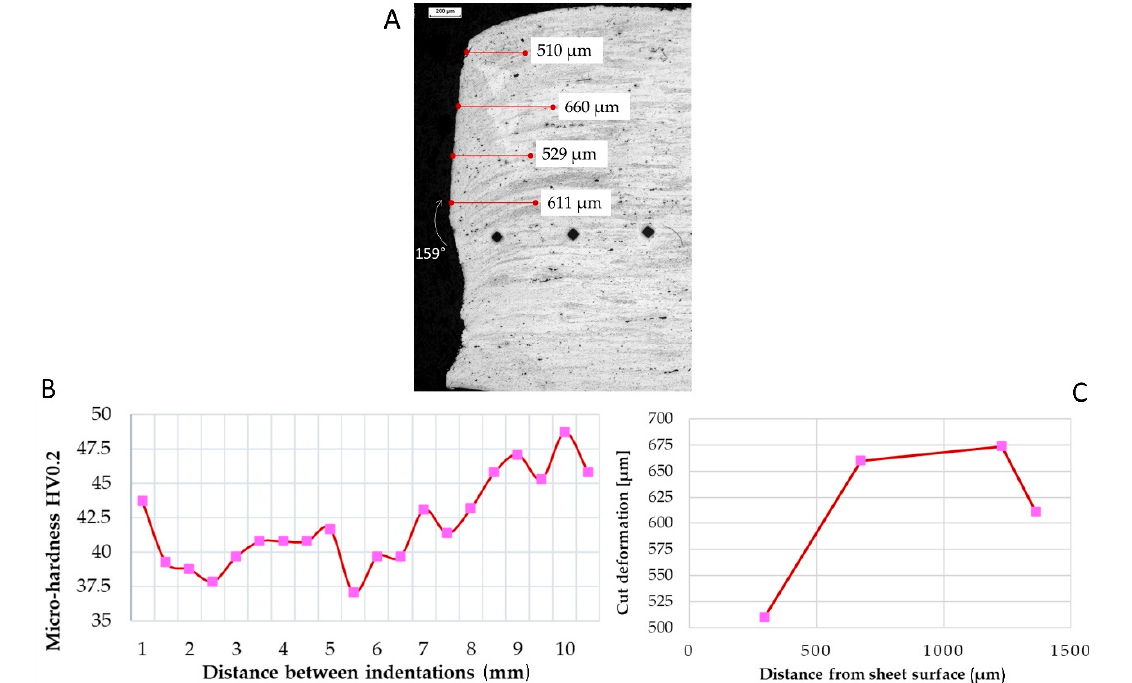
Figure 7. ( A ) Microscope image of the plasma cutting trace on AA1070 sheet. ( B ) Distortions in the first 1400 µm were documented. ( C ) Micro-hardness measured along the first 10 mm starting from the cut edge. Marker: 200 µm.